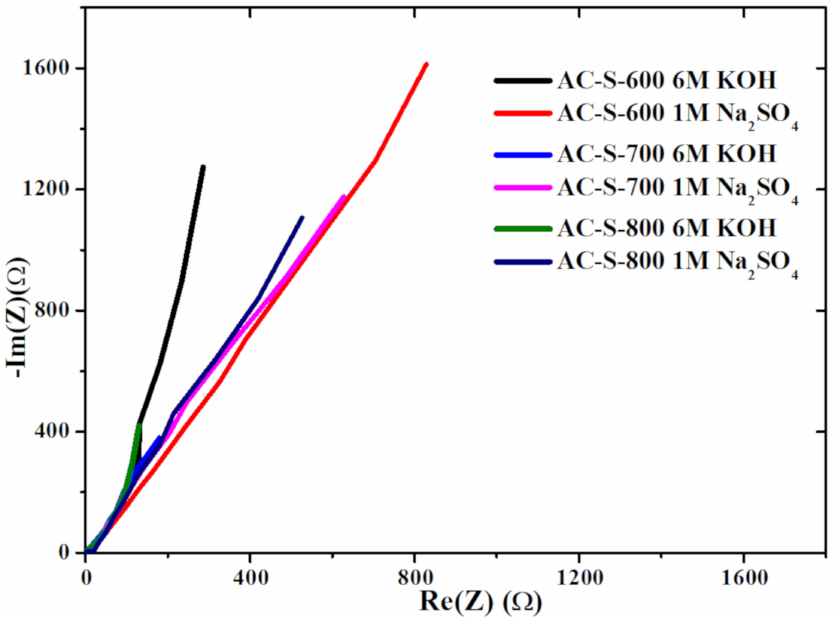
Figure 9. Electrochemical Impedance Spectroscopy (EIS) Nyquist plot for AC-S-600, AC-S-700 and AC-S-800 for two di ff erent electrolytes (6 M KOH and 1 M Na 2 SO 4 ) at the potential of 10